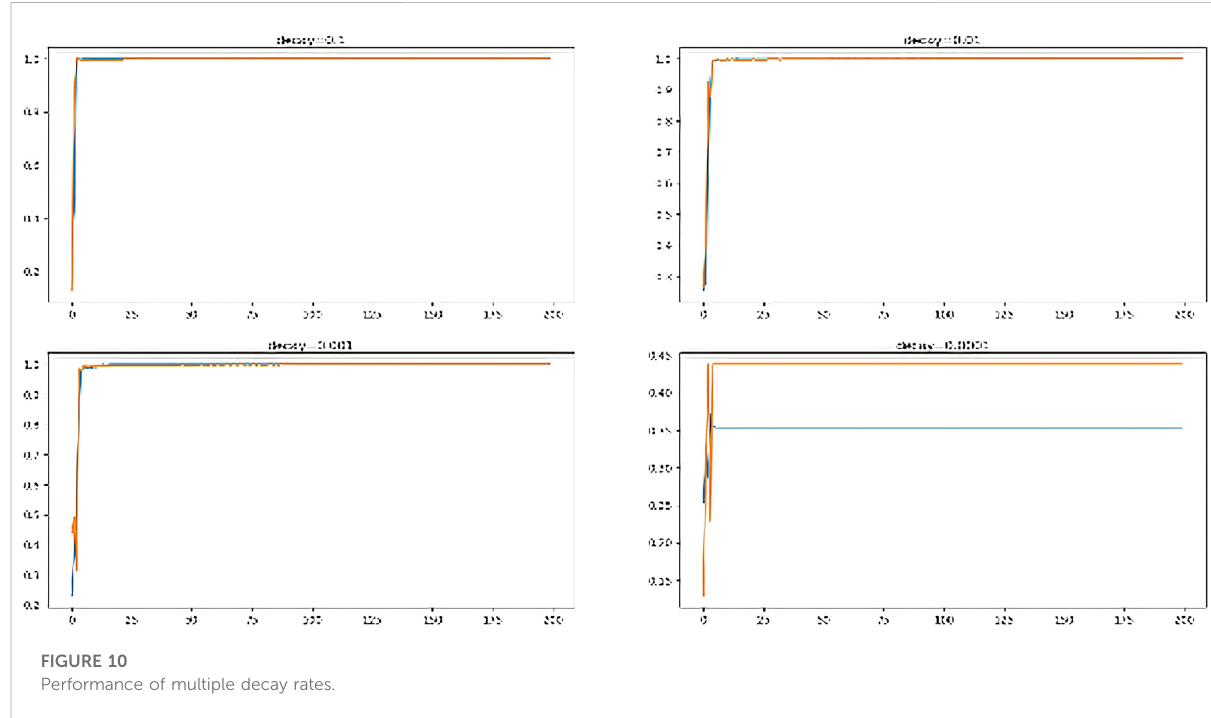
FIGURE 10 Performance of multiple decay rates.